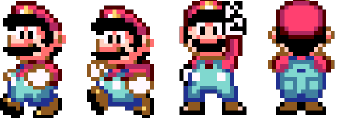
Fig. 3. Sprites where all pixels are connected. Source: Super Mario World© game.